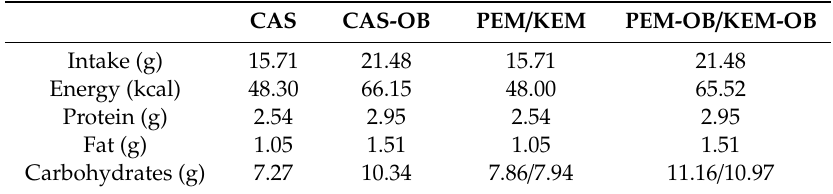
Table 3. Total daily feed intake (g / day) of rats fed casein or casein plus extruded mix diets either obesogenic or not for 21 days.